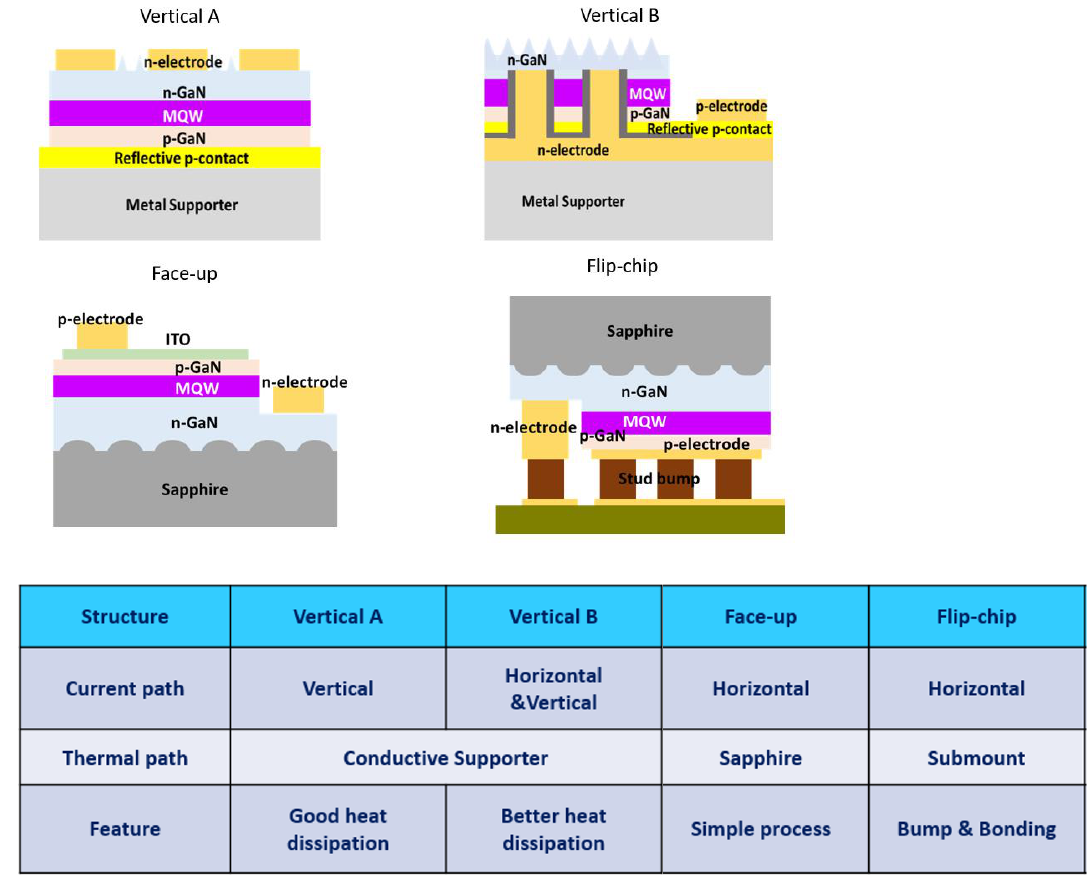
Figure 1. Common UV LED structures separated by fabrication methods.